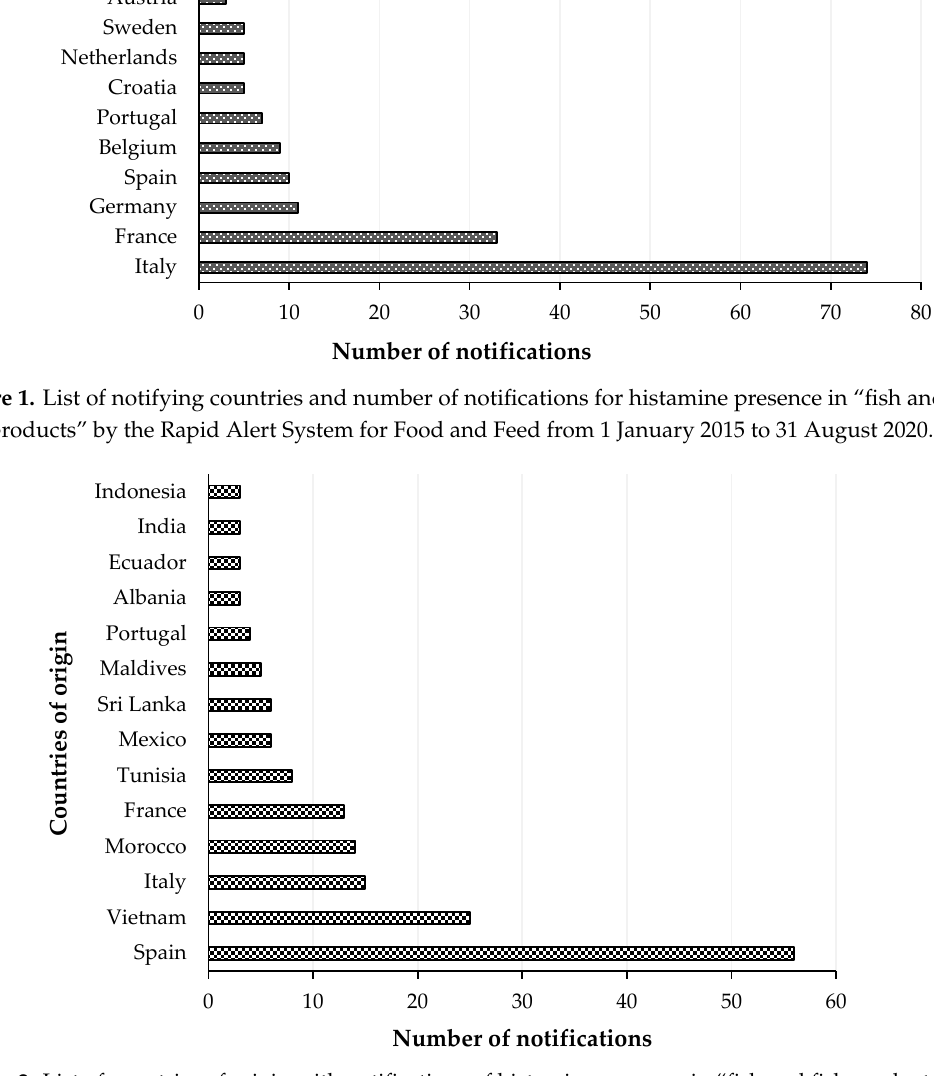
Figure 2. List of countries of origin with notifications of histamine presence in “fish and fish products” by the Rapid Alert System for Food and Feed (RASFF) from 1 January 2015 to 31 August 2020.